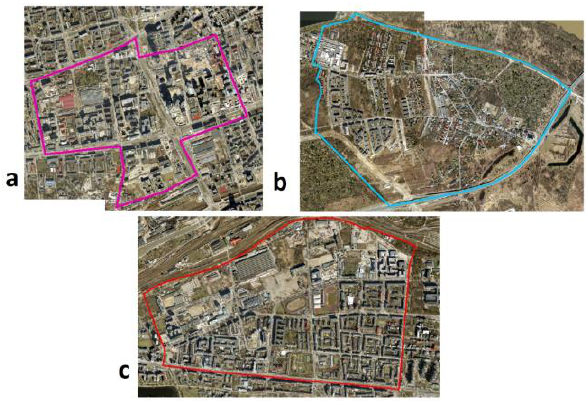
Figure 2. Selected regions for building change detection (a - central area with higher overlap, b - suburban area, c - former industrial